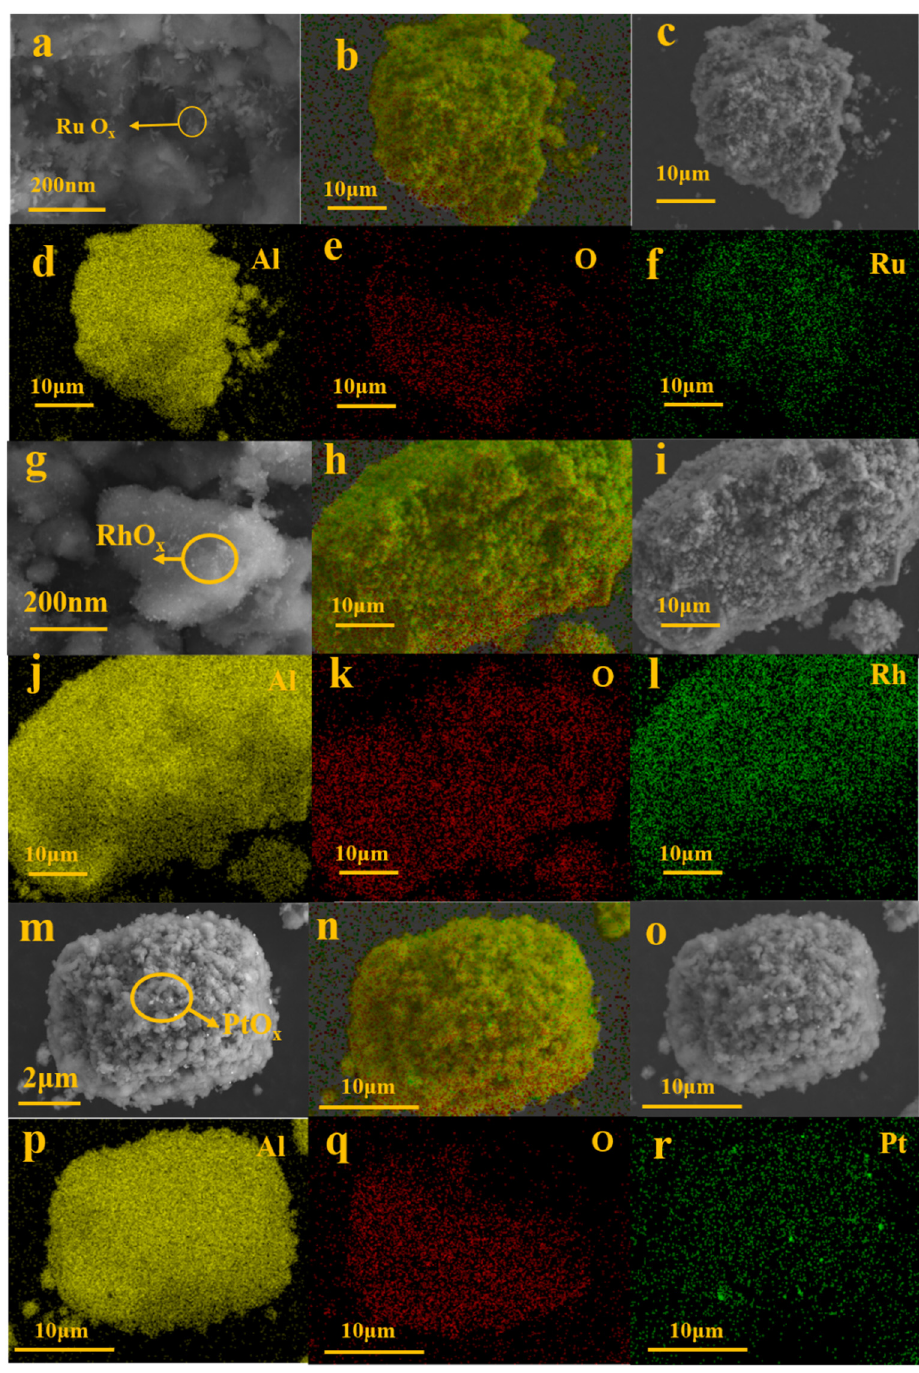
Figure 4. FE-SEM images of ( a ) Ru/ γ -Al 2 O 3 , ( g ) Rh/ γ -Al 2 O 3 , ( m ) Pt/ γ -Al 2 O 3 ; EDS elemental mapping of (b, d – f ) Ru/ γ -Al 2 O 3 , (h, j – l ) Rh/ γ -Al 2 O 3 , (n, p – r ) Pt/ γ -Al 2 O 3 derived from the SEM images of ( c ), ( i ), and ( o ), respectively.